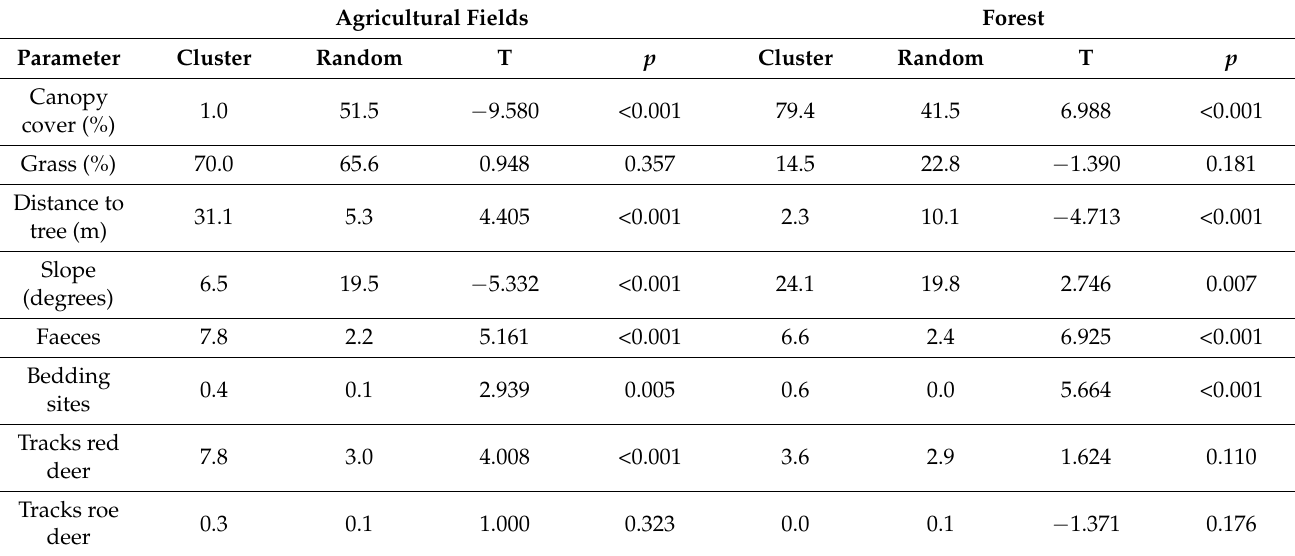
Table 1. Descriptive statistics (means) and t-tests comparing spatial clusters of red deer and paired random sites in agricultural fields and forest in Lærdal municipality, Norway, during winter 2019. Agricultural Fields